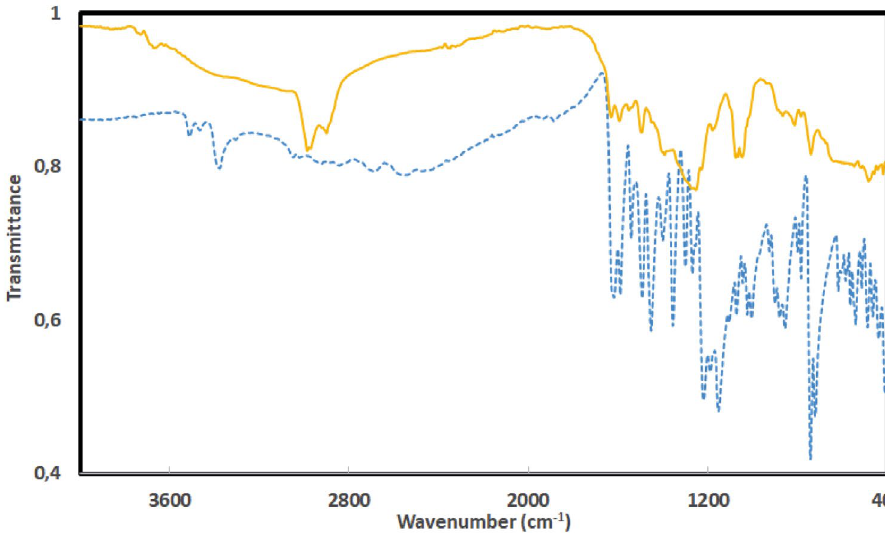
Fig. 6. The FT-IR (ATR) spectra of SK-1 with (1.0 equiv of Al 3+ ) and without Al 3+